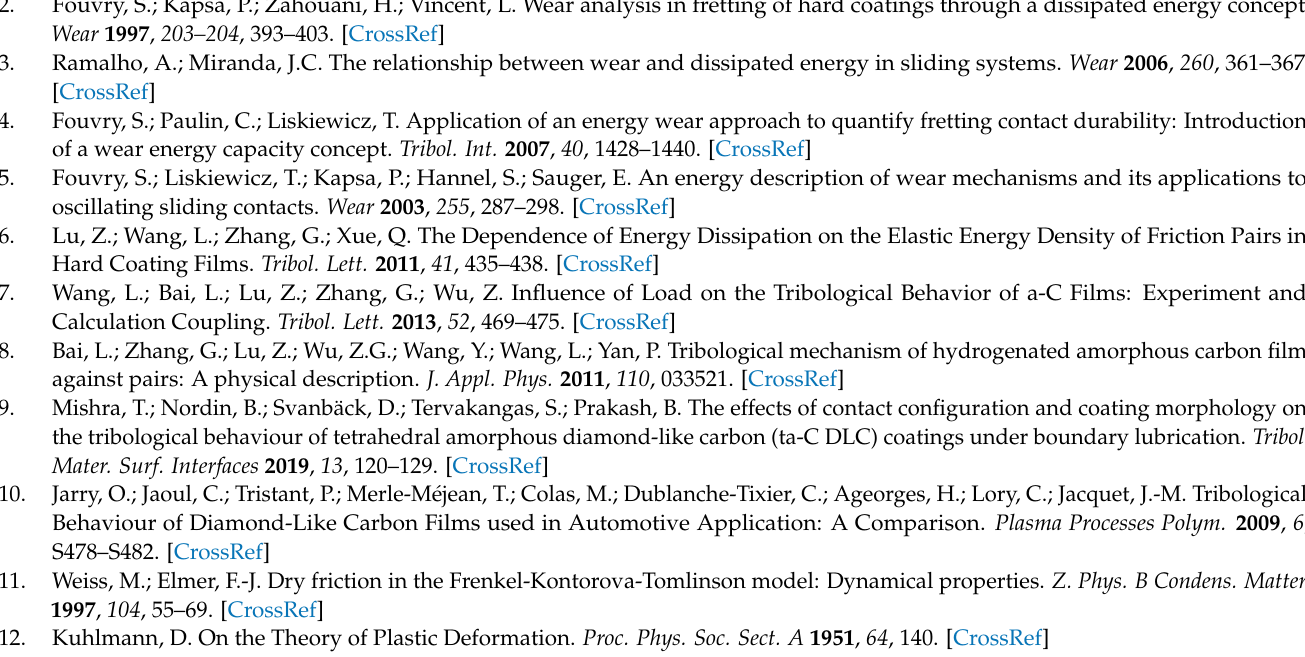
OVITO; Figure S2: The evolution of friction force F f with L under different conditions: (a) V x = 1 Å/ps, T = 300 K; (b) F n = 392 nN, T = 300 K; (c) F n = 392 nN, V x = 1 Å/ps; Figure S3: The sp 2 ratio of the transfer layer with L under different load conditions; Figure S4: The nanoindentation curve of DLC film; Figure S5: The evolution of wear energy E w under different conditions: (a) V x = 1 Å/ps, T = 300 K; (b) F n = 392 nN, T = 300 K; (c) F n = 392 nN, V x = 1 Å/ps; Figure S6: The evolution of friction energy E f under different conditions: (a) V x = 1 Å/ps, T = 300 K; (b) F n = 392 nN, T = 300 K; (c) F n = 392 nN, V x = 1 Å/ps; Figure S7: The evolution of various energy dissipation forms with sliding distance at F n = 78 nN, V x = 1 Å/ps, T = 300 K; Figure S8: The evolution of various energy dissipation forms with sliding distance at F n = 196 nN, V x = 1 Å/ps, T = 300 K; Figure S9: The evolution of various energy dissipation forms with sliding distance at F n = 588 nN, V x = 1 Å/ps, T = 300 K; Figure S10: Evolution of the proportion of various energy dissipation forms under different V x at F n = 392 nN, T = 300 K: (a) f w ; (b) f p ; (c) f e ; (d) f k ; (e) f t ; Figure S11: Evolution of the proportion of various energy dissipation forms under different T at F n = 392 nN, V x = 1 Å/ps: (a) f w ; (b) f p ; (c) f e ; (d) f k ; (e) f t ; Video S1: 78nN; Video S2: 196nN; Video S3: 392nN; Video S4: